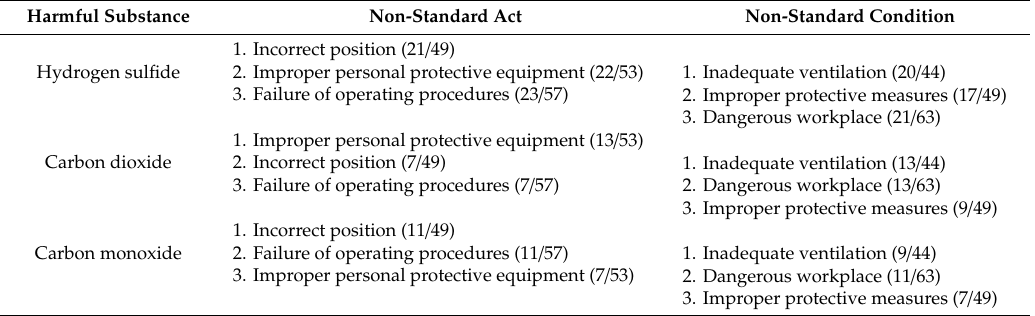
Table 5. Key causes of exposure to harmful substances by non-standard acts and non-standard conditions analyzed in this study.